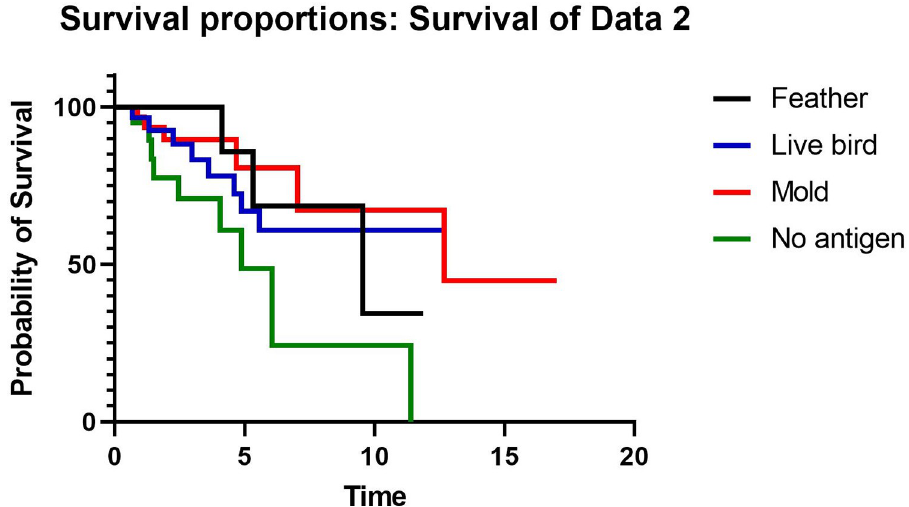
Fig 3. Kaplan-meier curve comparing transplant-free survival in years in patients with no antigen, feather, live bird, or mold.